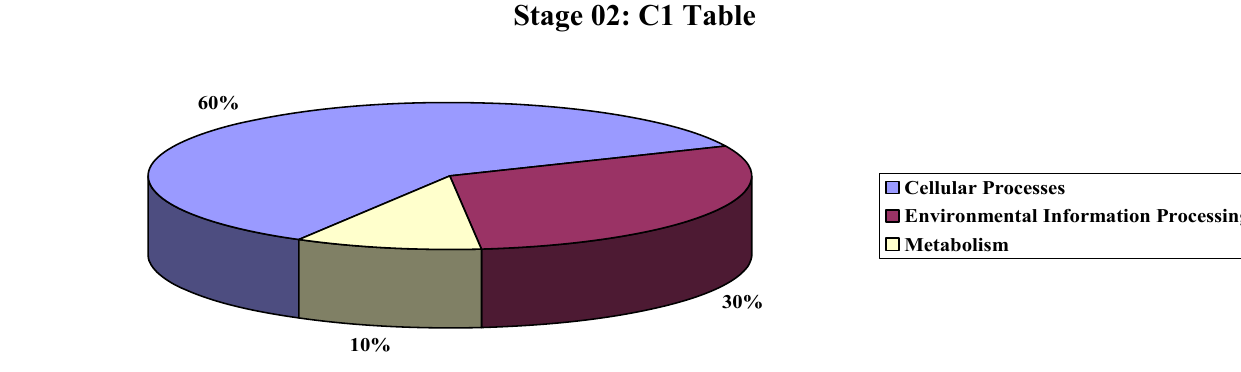
Figure 2. KEGG pathway analysis of the differentially expressed genes at stage 02.